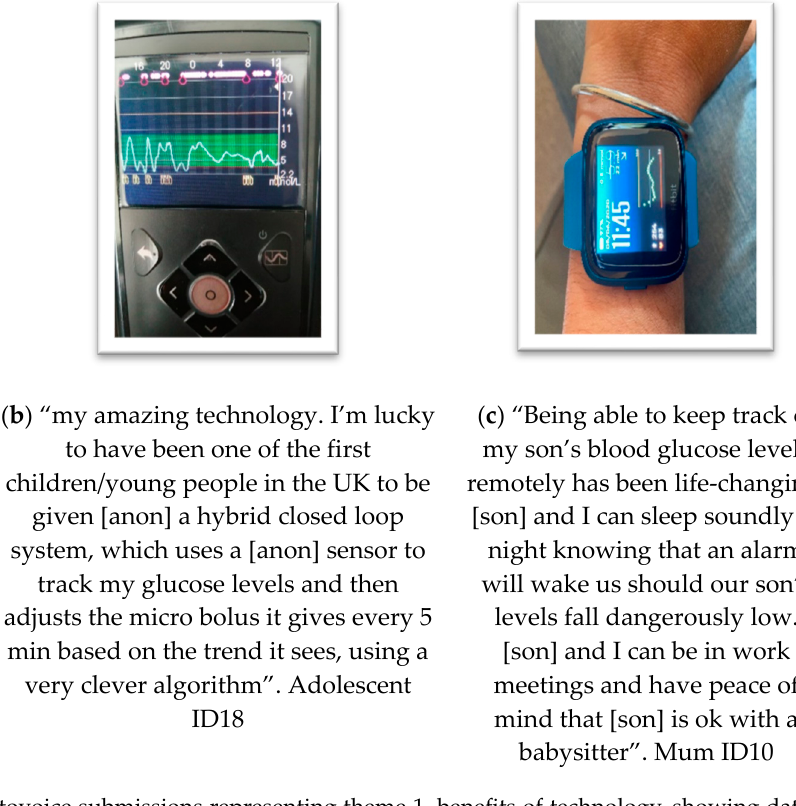
Figure 2. Photovoice submissions representing theme 1, benefits of technology, showing data interpreted as the following sub-themes: ( a ) communication and immediate support; ( b ) passivity; ( c )